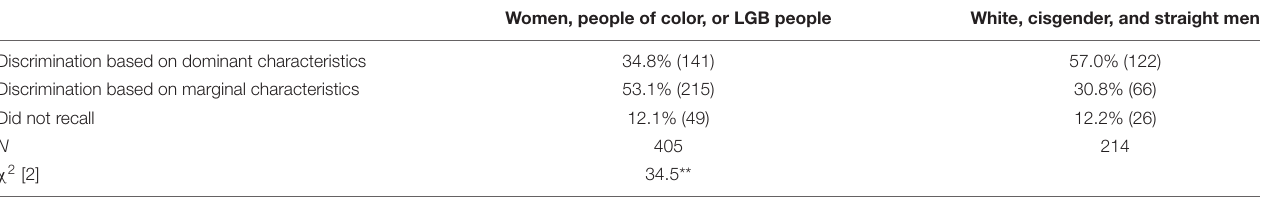
TABLE 1 | The type of discrimination recalled in the exercise (Study 1).